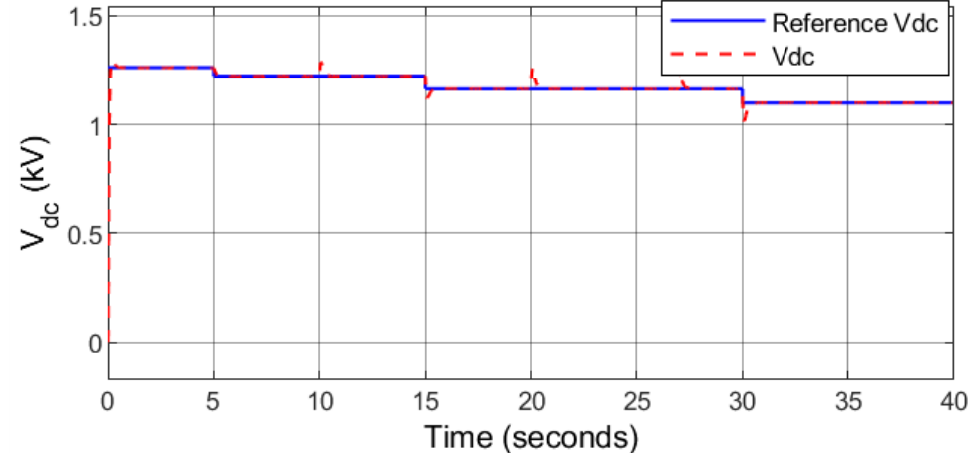
Figure 11. Scenario 3: tracking performance of the DC-link